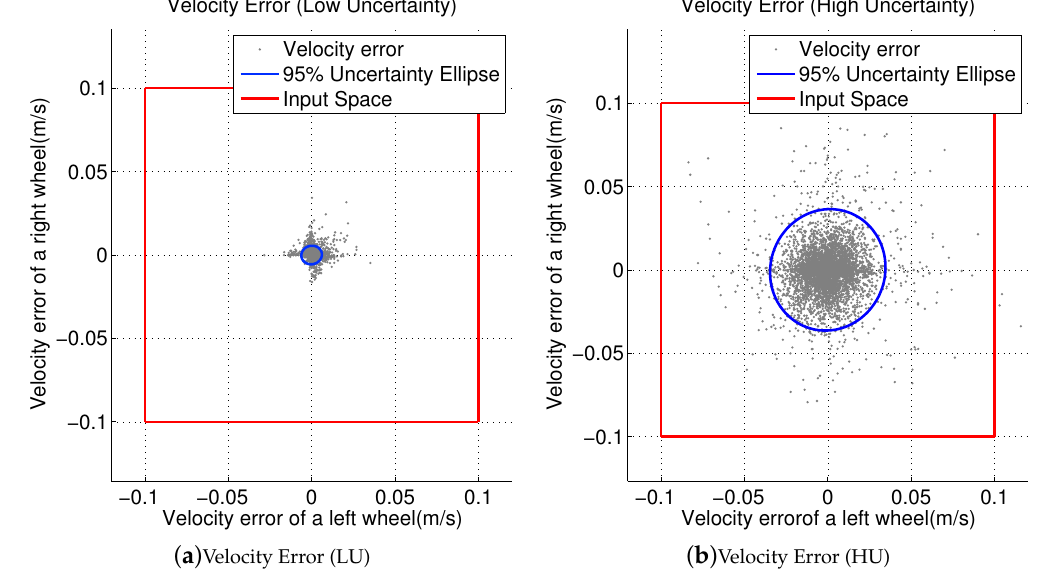
Figure 5. Uncertainty of the experimental resultant velocity in the input space. LU, low uncertainty; HU, high